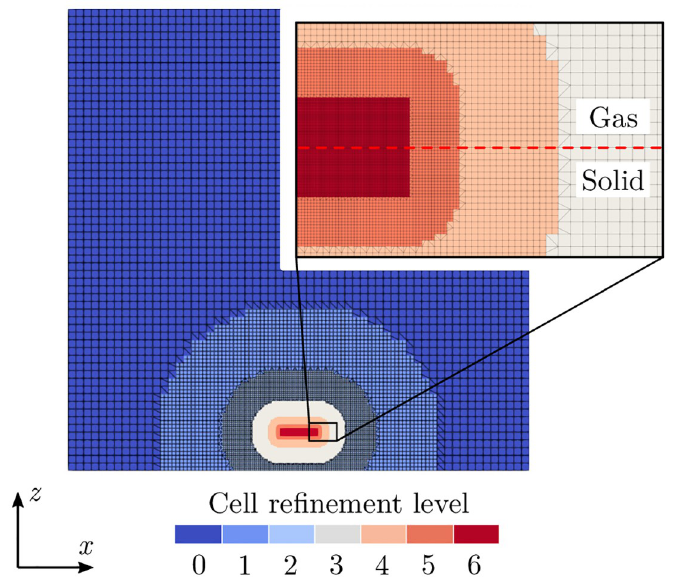
imum Courant number of below 0.05 throughout the simulations. The computation ends after 1.5 × 10 − 7 s for the parallel orientation of polarization vectors and after 6 × 10 − 7 s for the radial orientation. At those time steps, the maximum temperature in the computational domain is